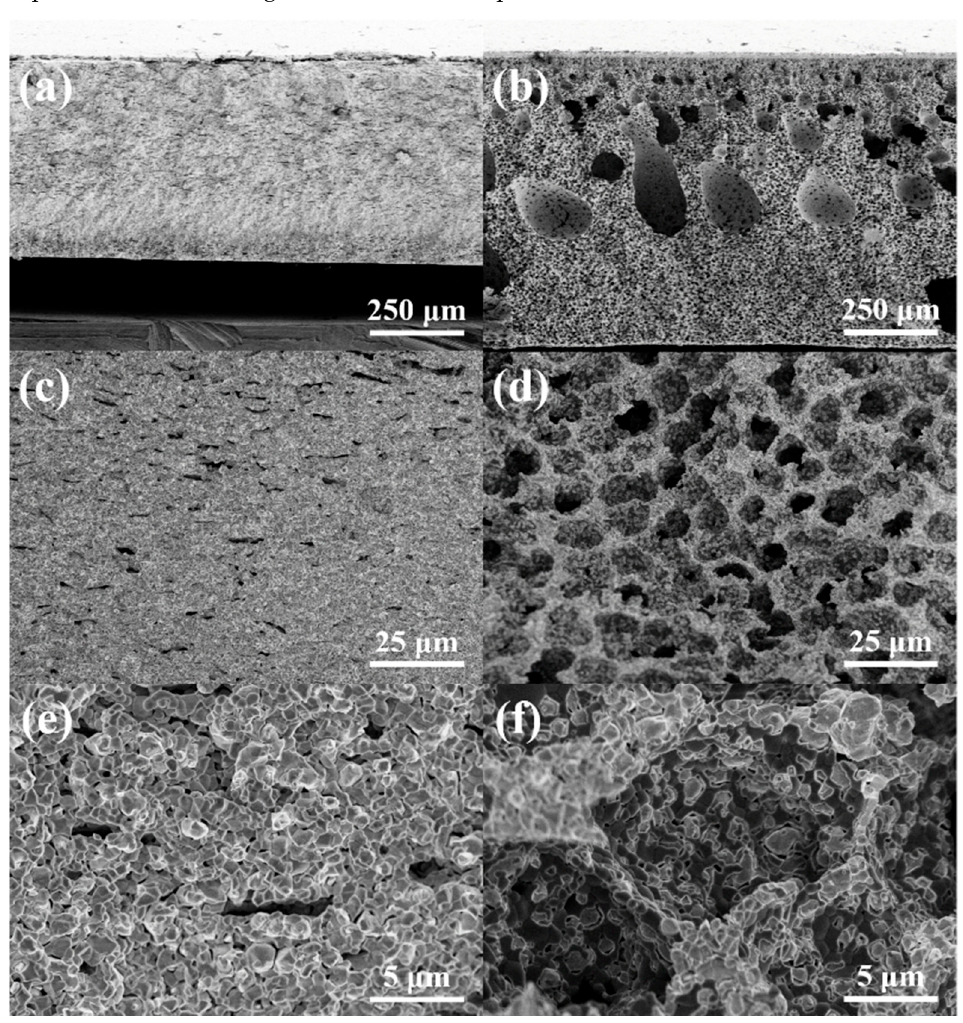
Figure 2. The cross-sectional FE-SEM images of tape-casting ( a , c , e ), and phase-inversion tape-casting ( b , d , f ) hydrogen electrodes after the cell test (reduced).